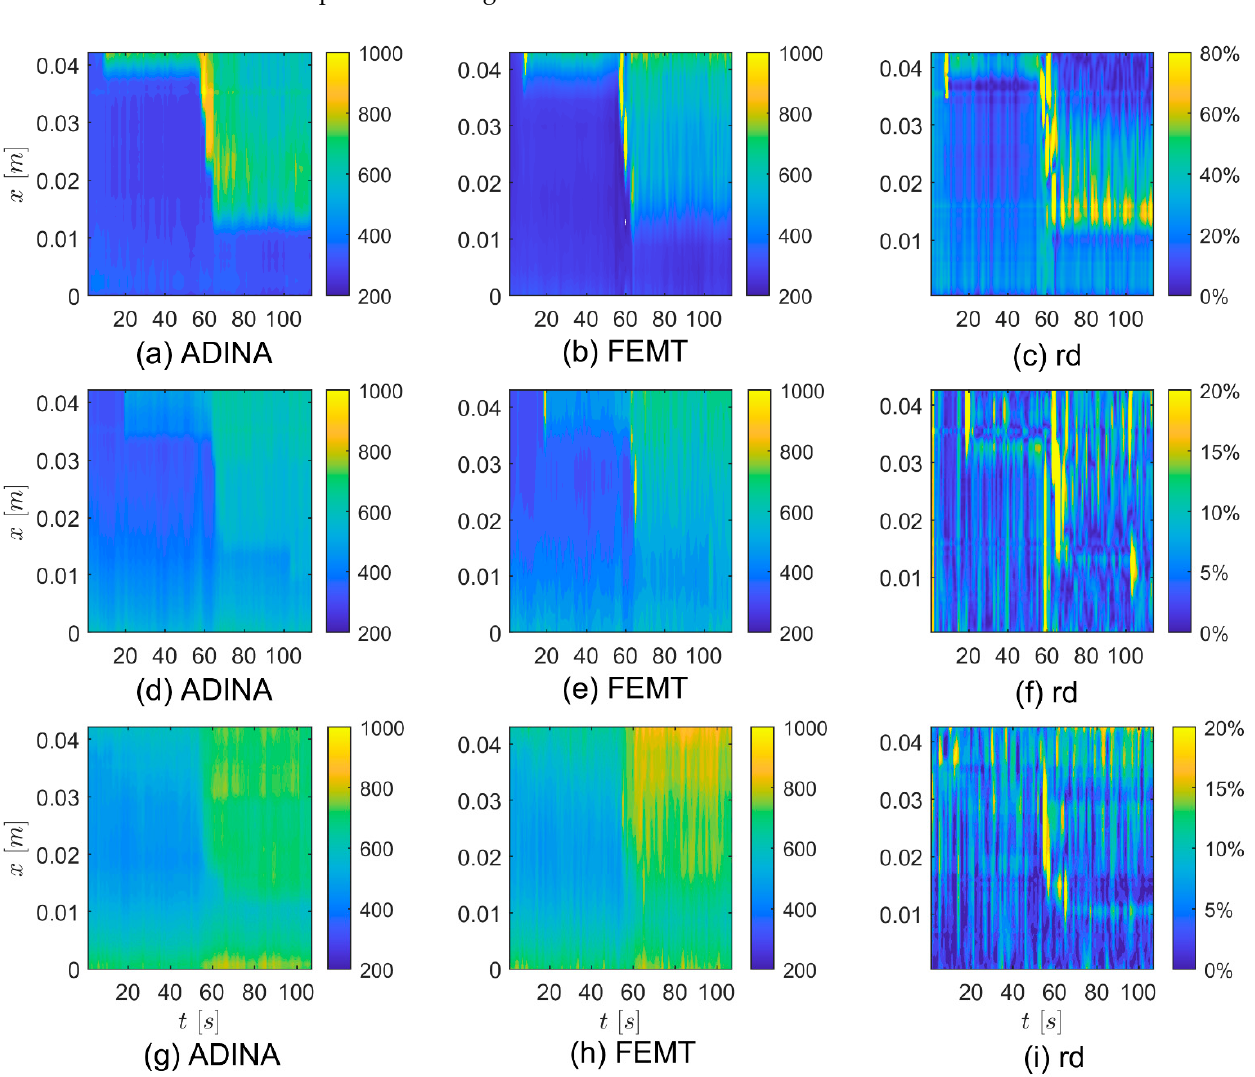
calculation methods (ADINA and FEMT) for the selected mass flow rate ( Q m = 55 [ kg/h ] ), is presented in Figure 10h.